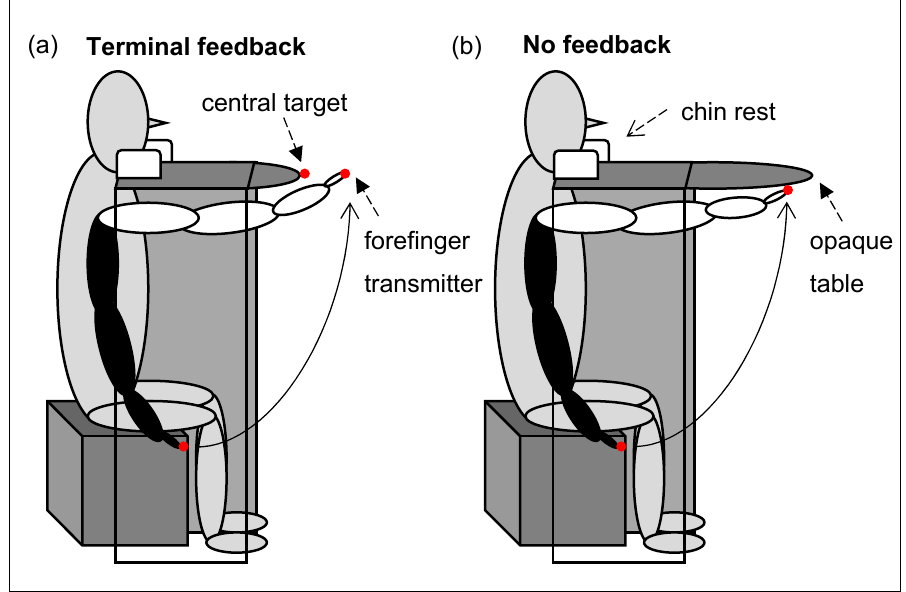
Figure 5. Participant executing a pointing movement towards ( a ) the central target with terminal feedback; ( b ) straight ahead without feedback. The black arm describes the starting position, the white arm the movement endpoint. The red dots depict the central target and the finger transmitter.